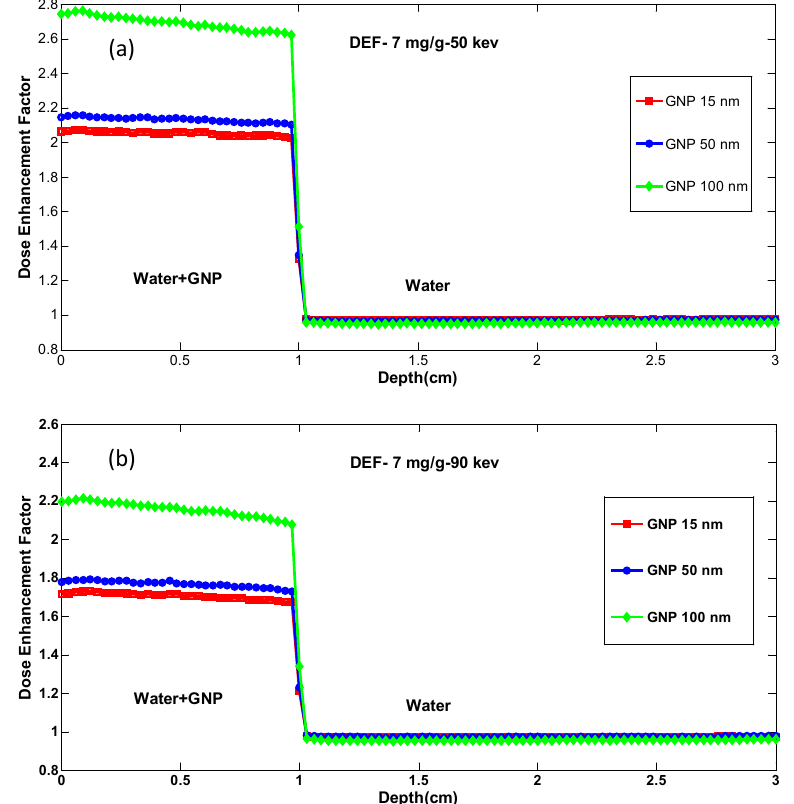
Fig. 2. The absorptive DEFs for GNPs with different dimensions: (a) energy of 50 keV, (b) energy of 90 keV